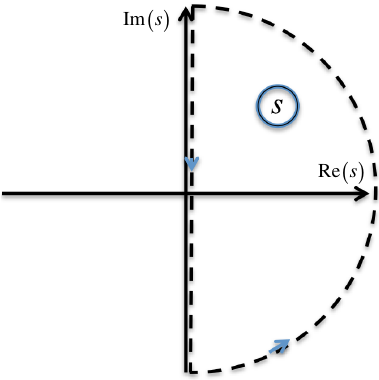
FIG. 3. The contour to determine the winding number encom- passes the right